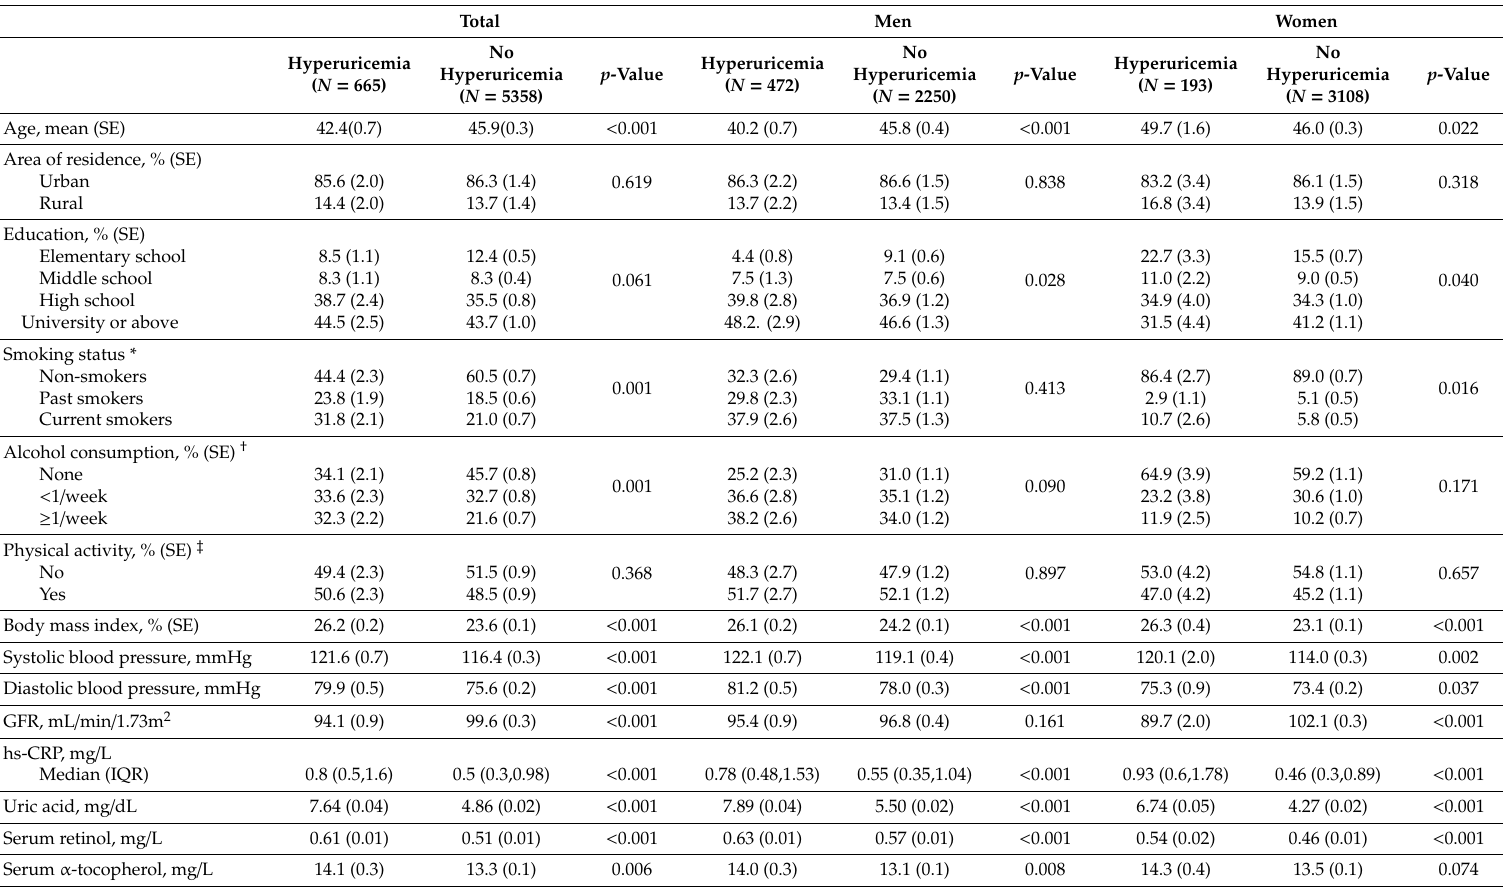
Table 1. General characteristics of study